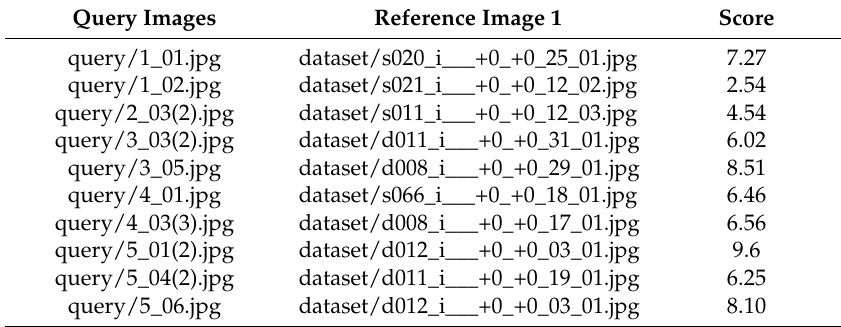
Table 3. Results of reference image extraction from the image DB of ETRI building using CDVS.